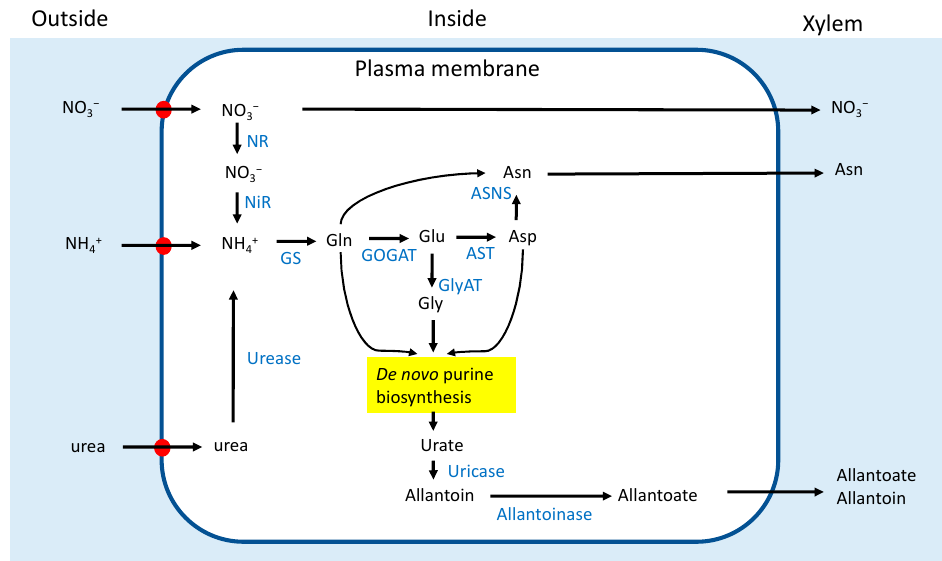
Figure 1. Schematic outline of the absorption and assimilation of NO 3 − , NH 4+ , and urea in a root cell. Transporters. ASNS: asparagine synthetase; AST: aspartate aminotransferase; GlyAT: glycine aminotransferase; GOGAT: glutamate synthase; GS: glutamine synthetase (referred to [3,15]).